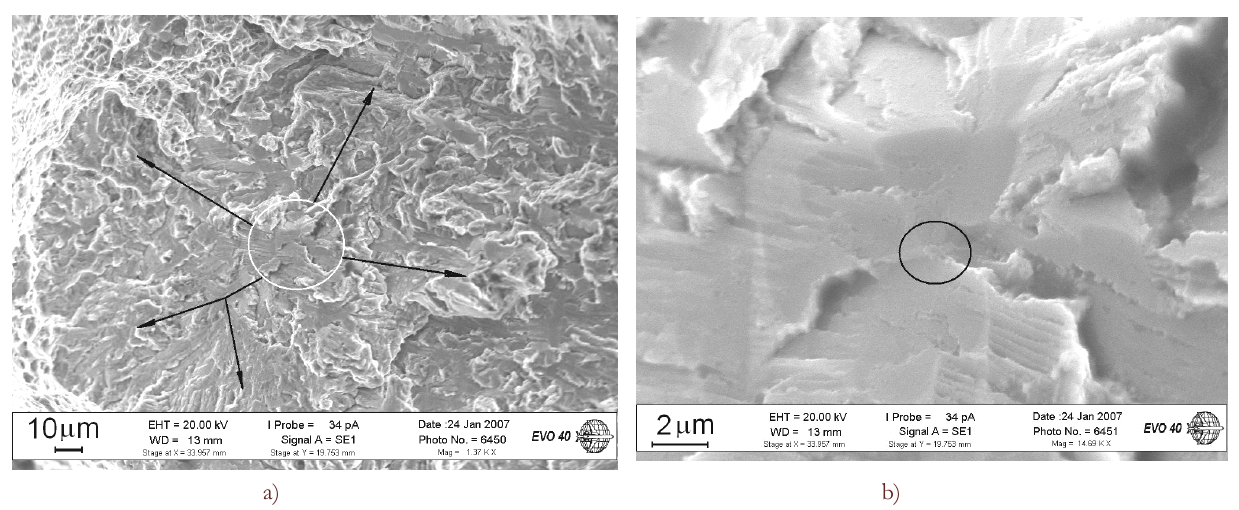
Figure 4: (a) TP-specimen fracture surface with a subsurface origin; (b) presented under different magnification. Area of origin placed inside of the circle. Smooth facet in (b) is area of the first step of crack initiation by the  - phase.